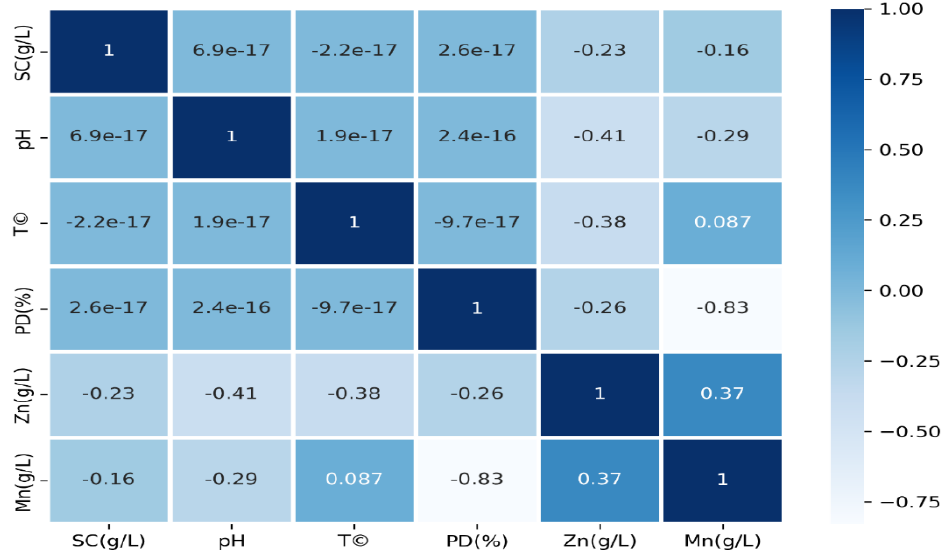
Figure 2. Correlation heatmap of input parameters and observed responses.